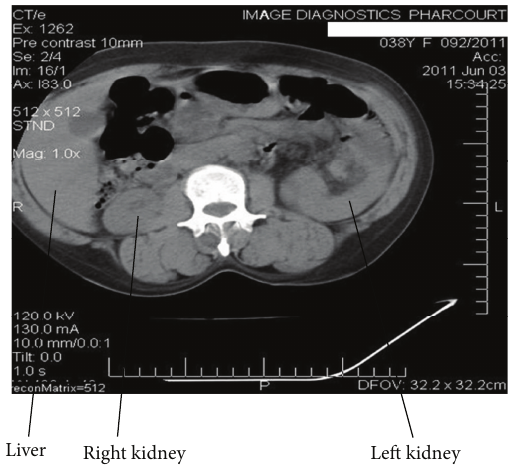
Figure 3: This CT slide shows both kidneys and the liver.